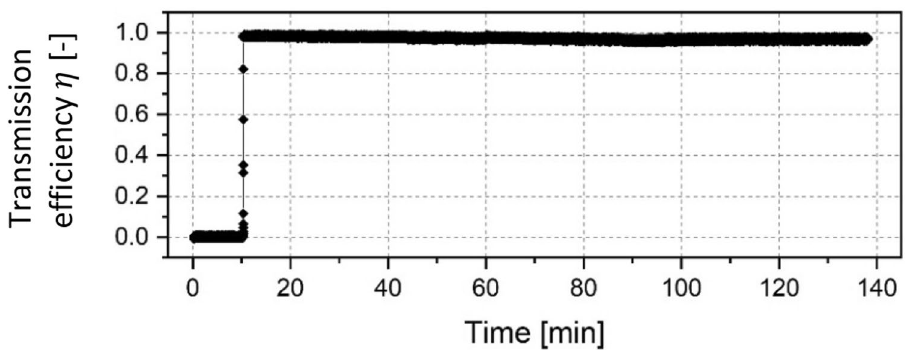
Figure 3. Normalized current transmitted through a 180° glass capillary with a primary particle energy of 15.5 keV. After around 140 min the on–off tests were conducted (see Fig.